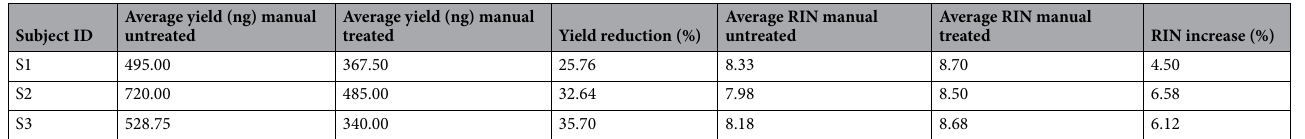
Table 2. RNA yield reduction and RIN increase induced by TURBO DNA Free treatment in the manual protocol.